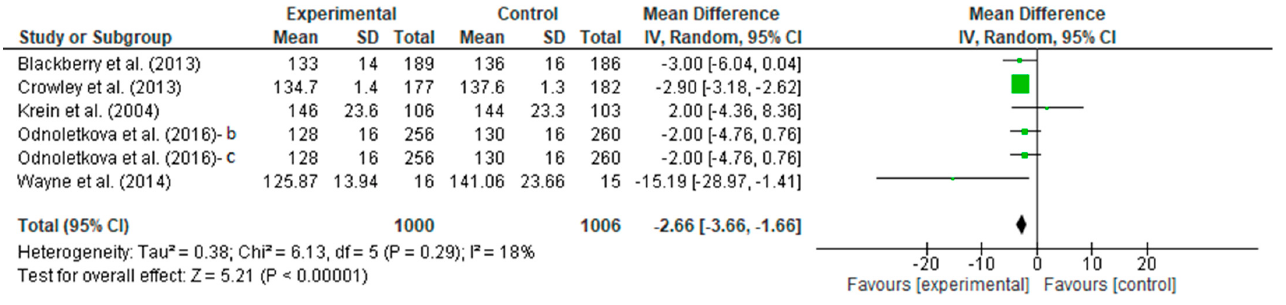
Figure 7. Forest plot intervention vs. control of telecoaching in achieving a SBP outcome [12–14,18,21,22].